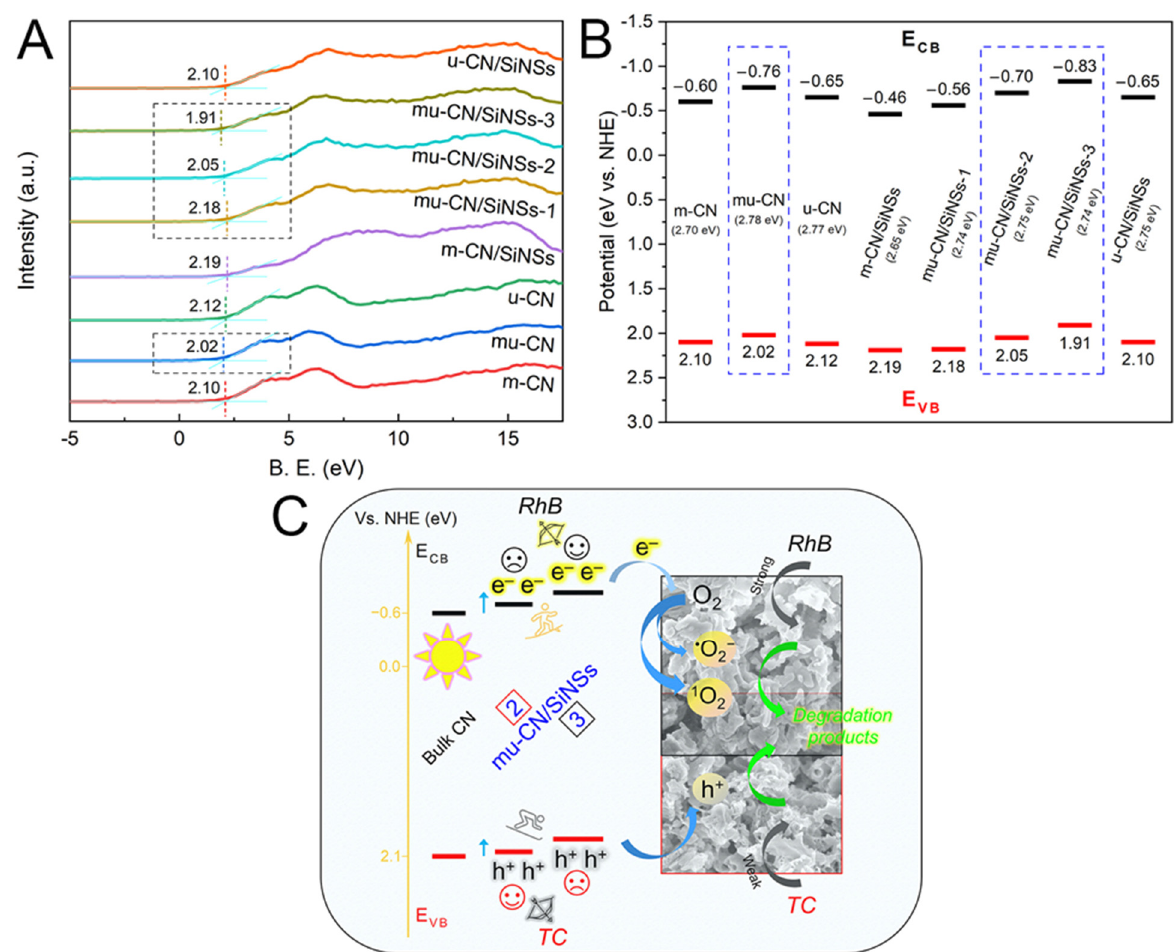
Figure 8. ( A ) VB-XPS spectra and ( B ) band structure of the CNs and CN/SiNSs composites; ( C ) sche- ( C ) schematic photocatalytic degradation mechanism of RhB and TC over the mu-CN/SiNSs-2, 3